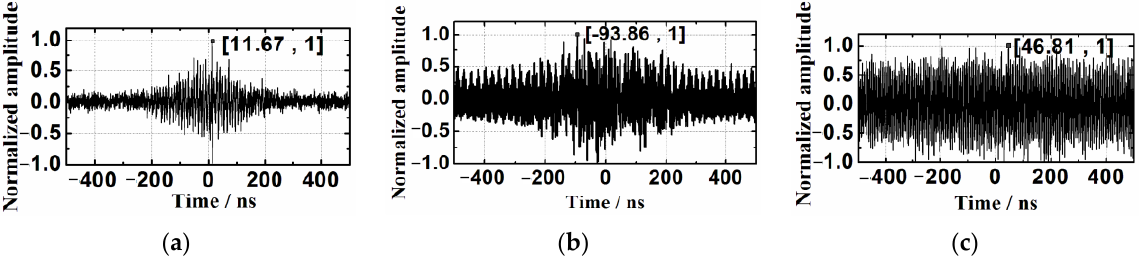
Figure 7. Comparison of time delay results using: ( a ) Method 1; ( b ) Method 2; ( c ) Method 3. N = 1000 times, SNR with Gaussian noise = − 30 dB. Narrow-band interference with the frequency 80 MHz, 100 MHz, and 150 MHz, and the corresponding amplitude are 0.05 V, 0.2 V, and 0.5 V is also added.